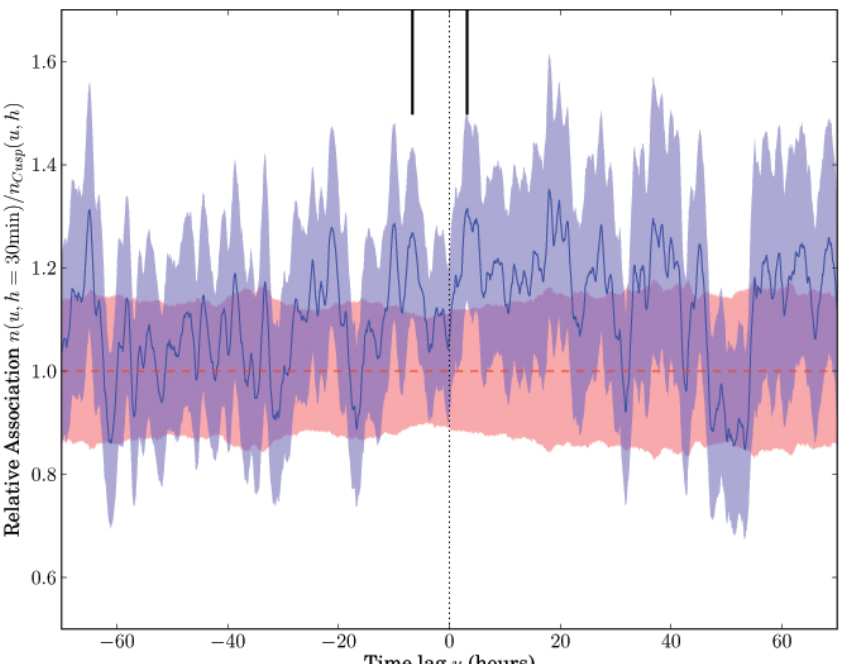
Fig. 5. Association of CEPs (blue) and cusp (red) with substorms detected by GOES dipolarizations. Normalized to match asymptotic association numbers and so cusp association is 1.0. Lines represent the calculated association number; shaded areas indicate 95% confidence intervals; overlapping c.i. are magenta. Heavy black lines mark features discussed in